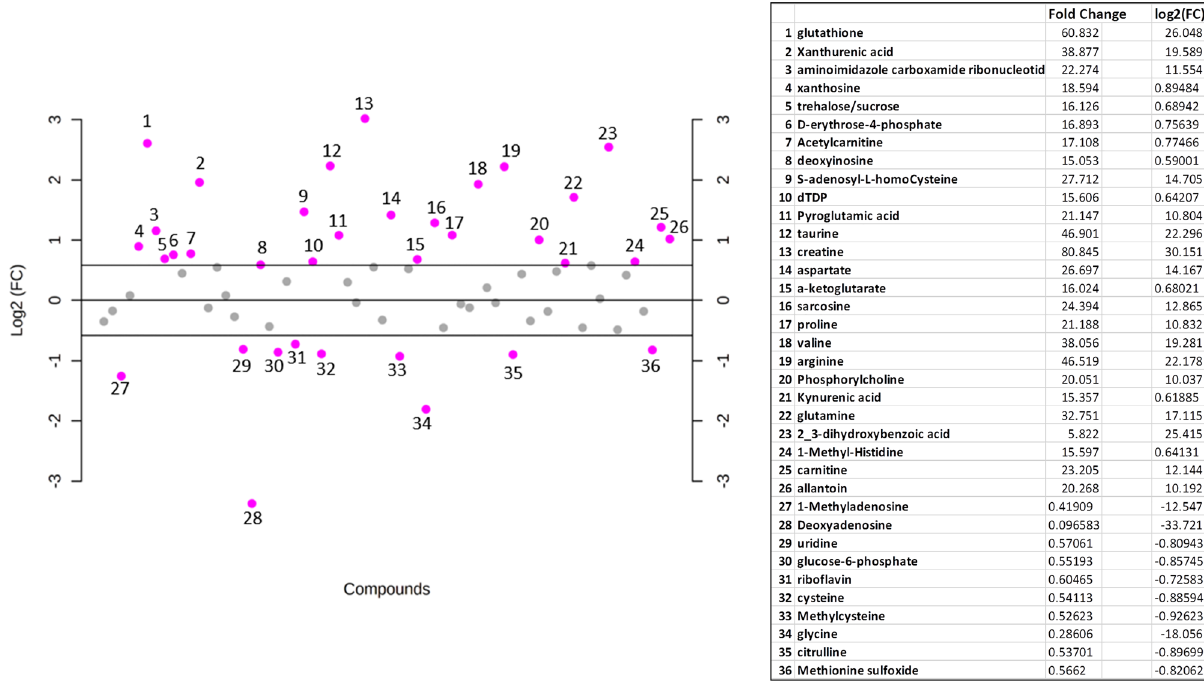
Figure 2. Fold change representation of all analysed metabolites. Data are log2-fold-change in relative abundance of untargeted metabolites in biological replicates of IgGm + relative to IgGm − . Dashed lines indicate a log2-fold-change of |1|. Purple dots indicate metabolites with >|1| log2-fold-change, and grey dots represent metabolites with <|1| log2-fold-change. The table represents 26 metabolites with the most significant changes in IgGm + ; 10 metabolites resulted in an increase in IgGm −